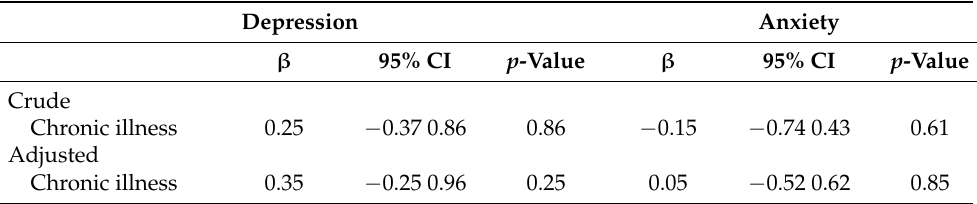
Table 4. Results from regression analyses between chronic illness and either